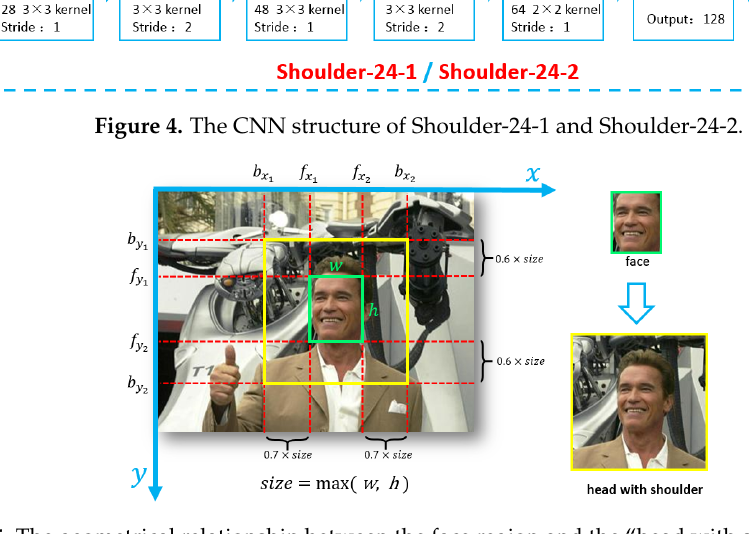
Figure 5. The geometrical relationship between the face region and the “head with shoulder”